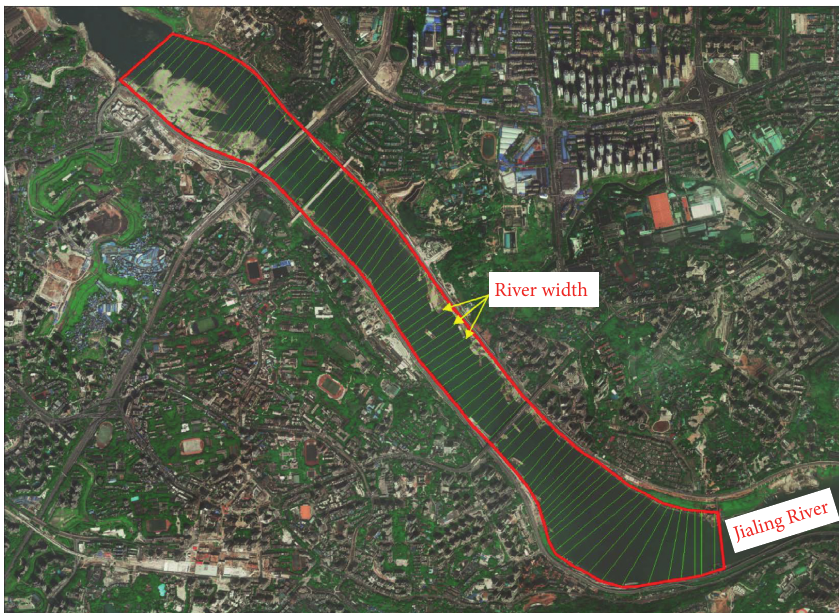
Figure 12: River width in the assessed area.